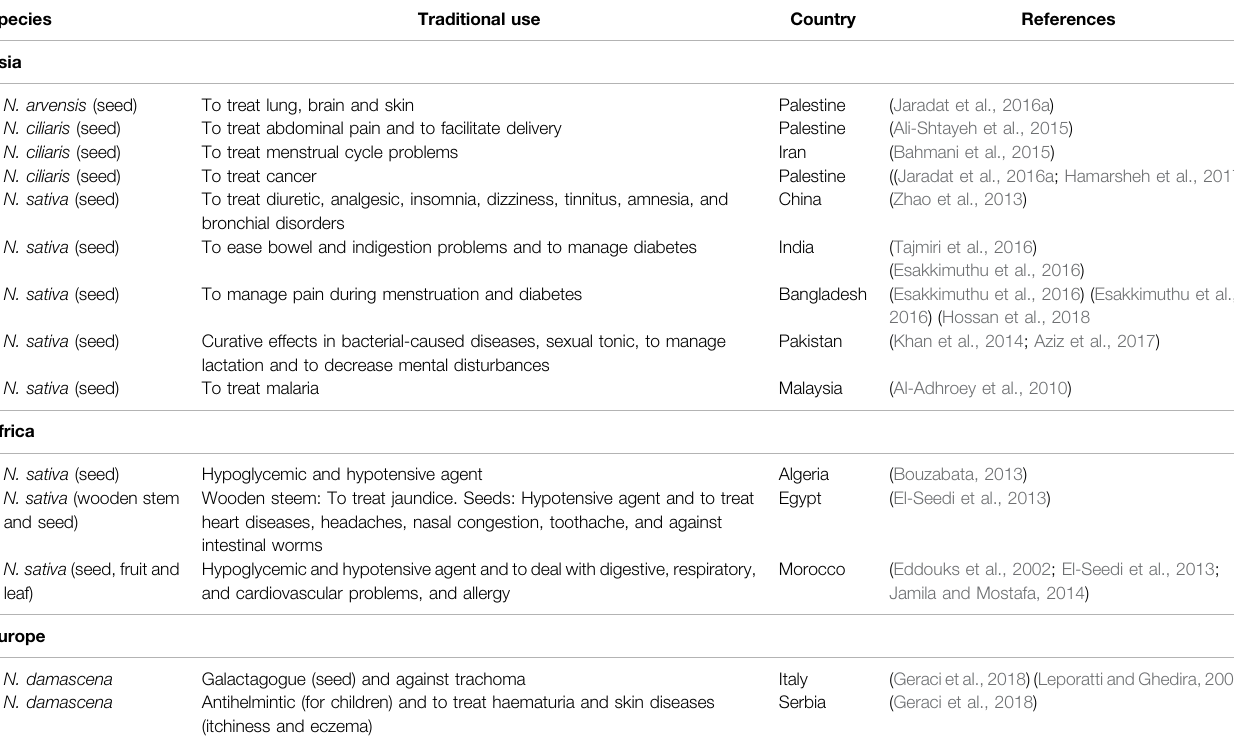
TABLE 1 | Some traditional uses of Nigella species.